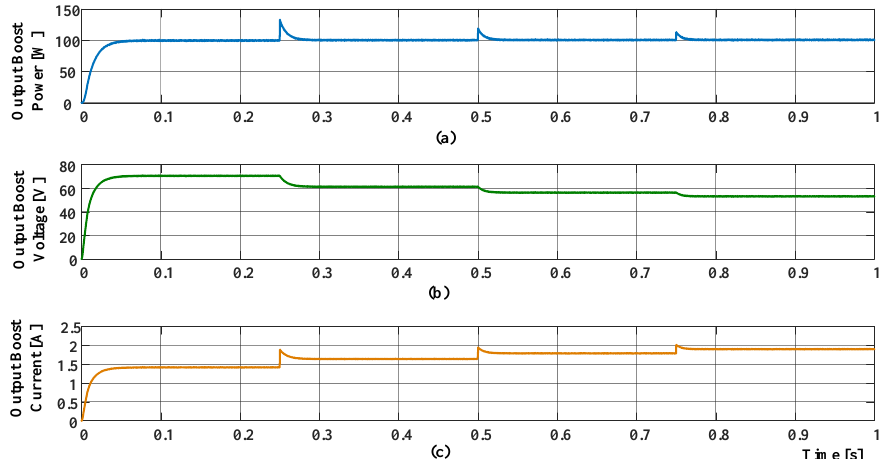
Figure 11. Simulation results considering the system operating in mode II ( MPPT test mode): ( a ) output power, ( b ) output voltage, and ( c ) output current of the boost converter controlled using the perturb and observe ( P&O ) MPPT algorithm.